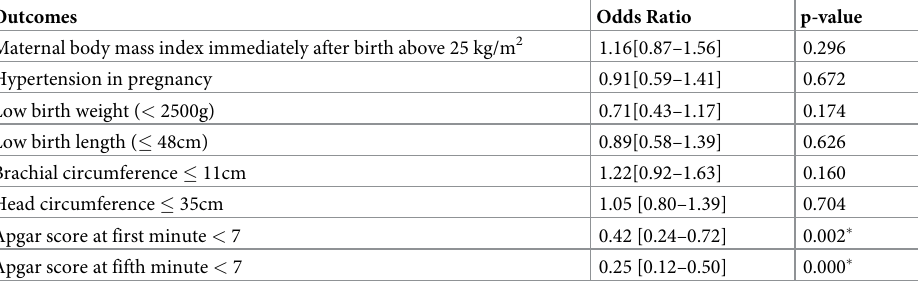
Table 3. Association of calcium supplementation in pregnancy with maternal and foetal